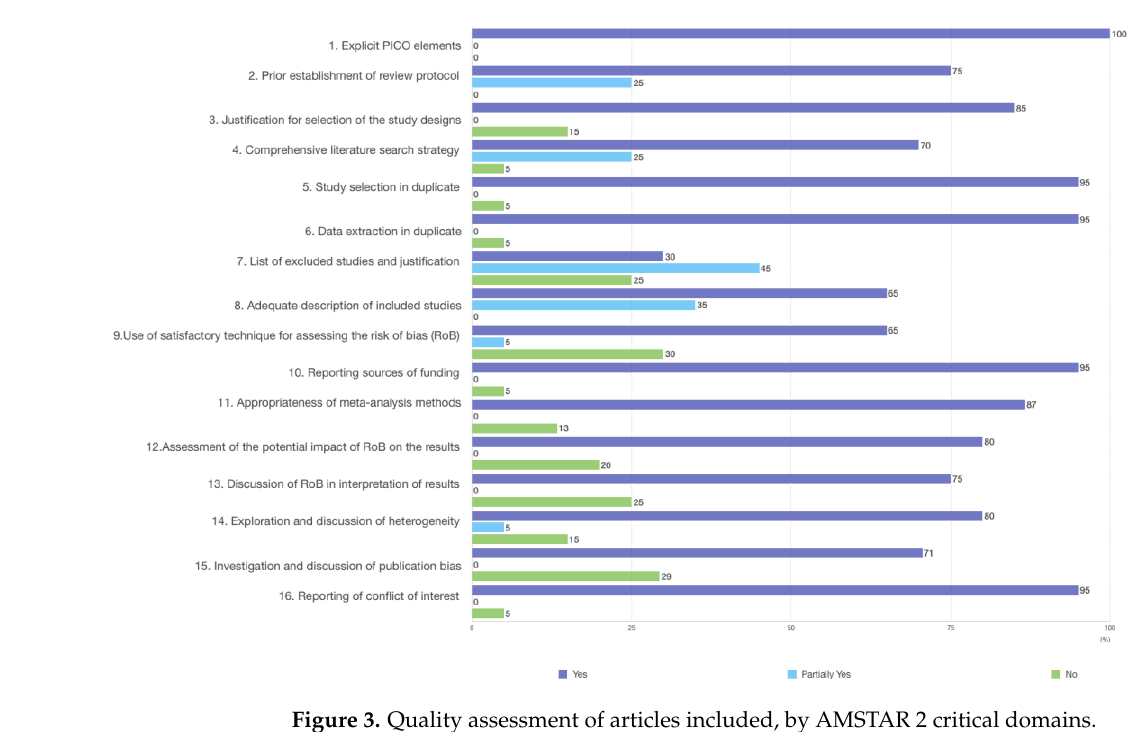
6 of 20 Figure 2. Methodological quality evaluation of articles included.